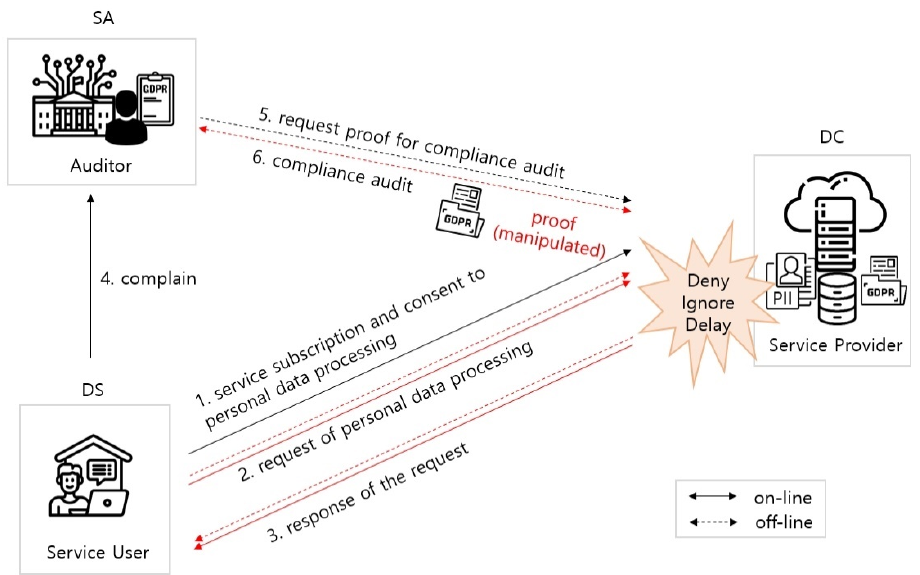
Figure 3. GDPR compliance audit scheme in a conventional centralized environment.